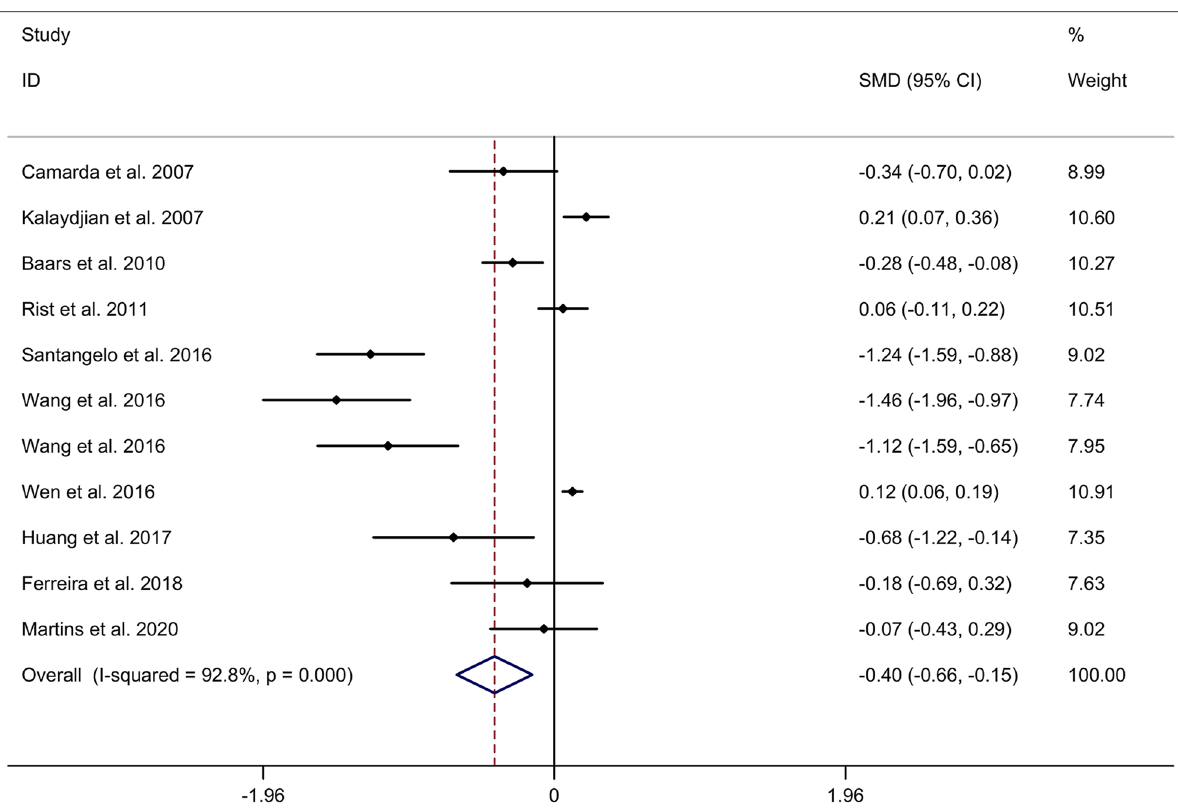
Fig. 1 Forest plots regarding comparison in general cognitive function between migraine group and no migraine group. Abbreviations: CI, confidence interval; SMD, standard mean